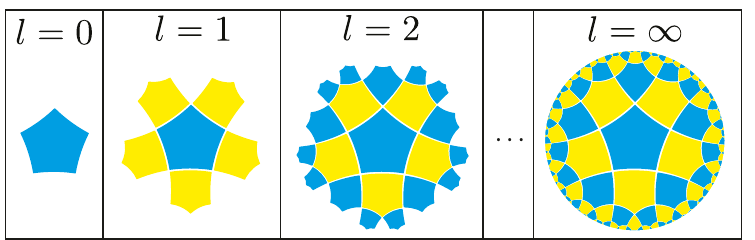
Figure 6. A tiling of the hyperbolic plane with a cutoff labeled by l . Increasing l by one amounts to adding an additional “layer” of pentagons.